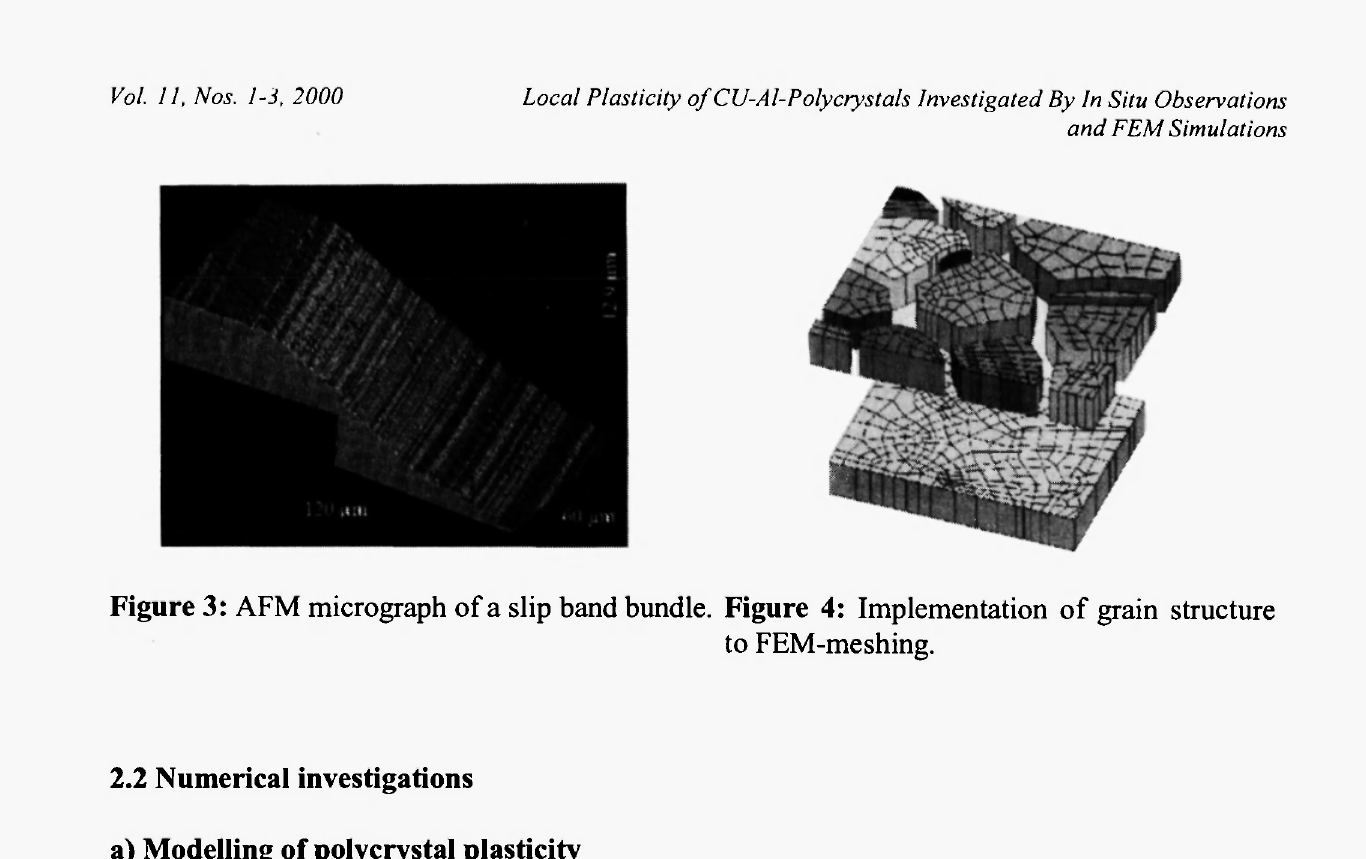
Figure 3: AFM micrograph of a slip band bundle. Figure 4: Implementation of grain structure to